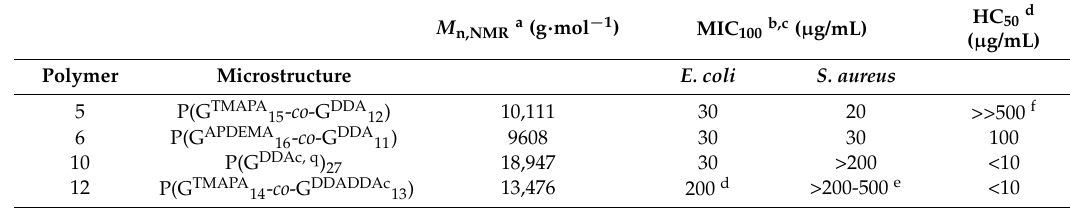
Table 1. Minimal inhibitory concentration against E. coli and S. aureus and hemolytic activity of functional polyglycidols with defined microstructures P(G TMAPA 15 - co -G DDA 12 ) ( 5 ), P(G APDEMA 16 - co - G DDA 11 ) ( 6 ), P(G DDAc, q ) 27 ( 10 ), P(G TMAPA 14 - co -G DDADDAc 13 ) ( 12